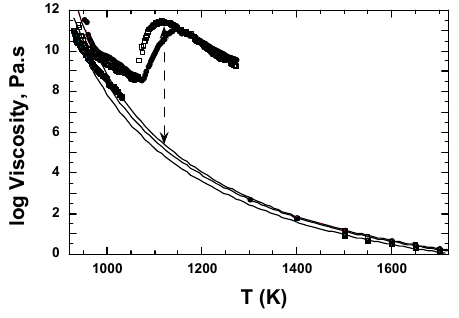
Figure 9: Increases of viscosity of basalt melts on heating due to partial crystallization of the material [12]. The monotonous curves extending to high temperatures show the viscosity decreases that would obtain if crystallization were not taking place. N.B. T (K) = T (°C) +